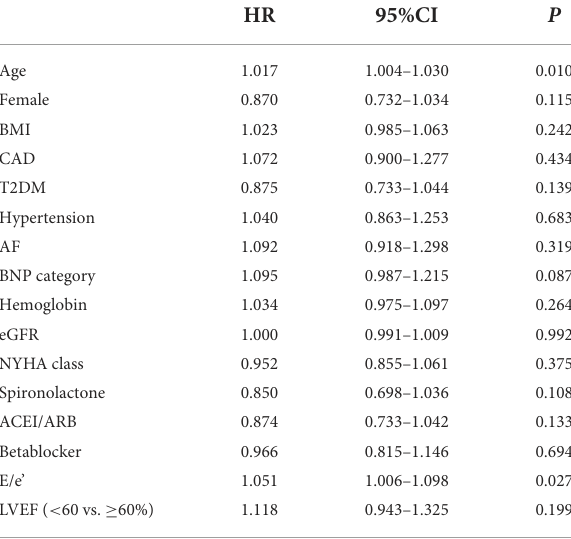
TABLE 2 Multivariable cox analysis for all-cause mortality in total HFpEF patients.